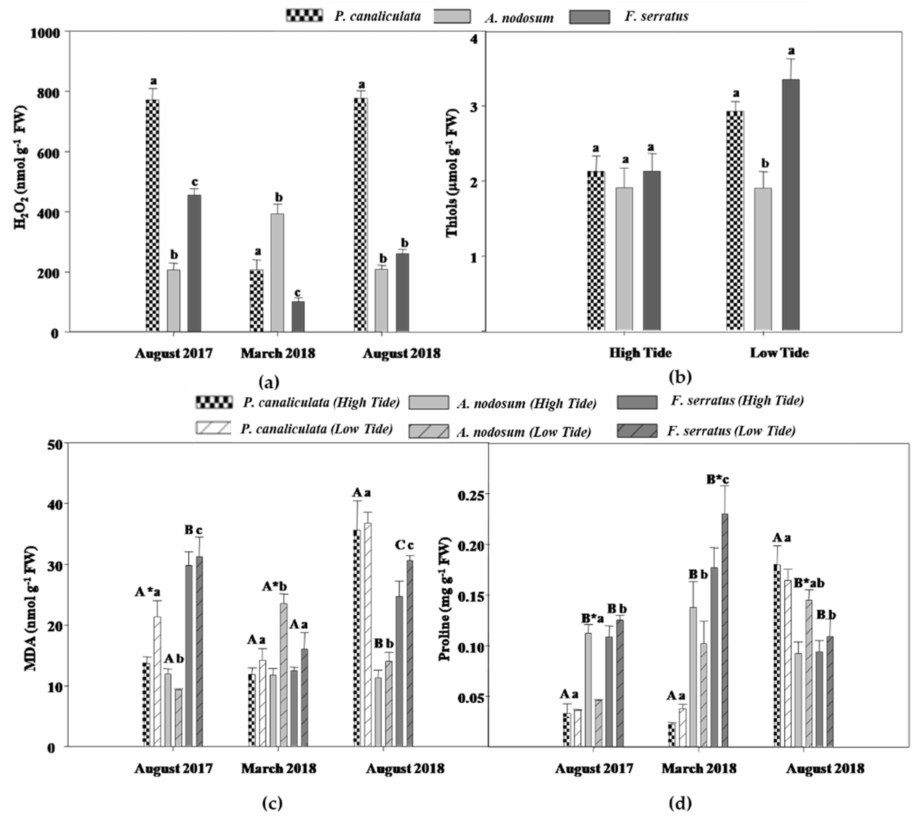
Figure 2. Oxidative stress indicators of P. canaliculata, A. nodosum , and F. serratus at low and high tide conditions in August 2017, March and August 2018. ( a ) H 2 O 2 . ( b ) Thiols. ( c ) MDA. ( d ) Proline. Data presented are mean ± STDEV ( n ≥ 3). * Above bars indicate significant statistical differences between tides at p ≤ 0.05. Different uppercase letters indicate significant statistical differences between species at high tide at p ≤ 0.05. Different lowercase letters indicate significant statistical differences between species at low tide at p ≤